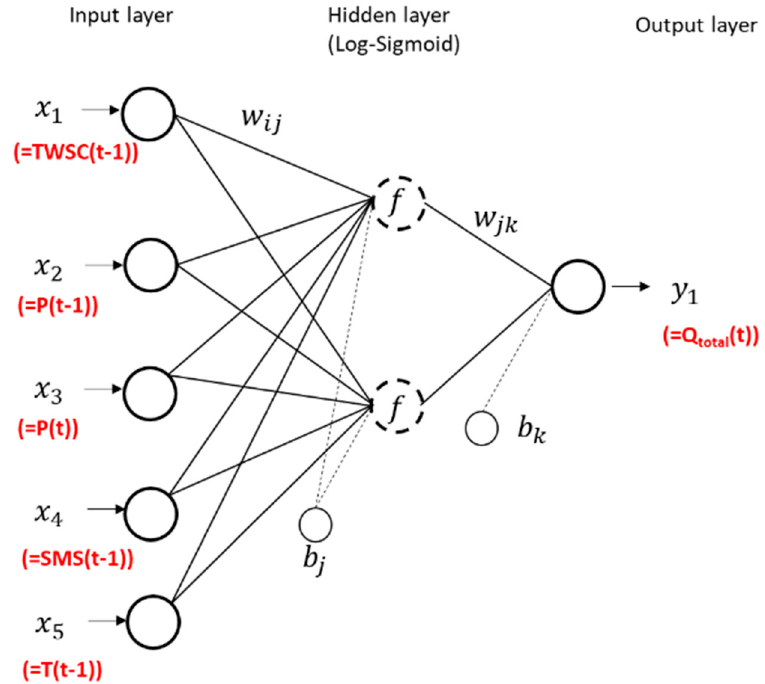
Figure 3. The artificial neural network (ANN) model architecture used for predicting total discharge. [ x ] are the input data, which are antecedent (t-1 indicates 1 month ahead) TWSC, precipitation (P), soil moisture (SMS), and average temperature (T). The prediction ( y 1 ) is the total discharge (Q total ). w ij and w jk denote connection weights, b j and b k are the bias term, and f represents the activation function (log-sigmoid). Table 3. Input data and target data corresponding to test cases. P: precipitation, T: average temperature, SMS: soil moisture, and IDW: inverse distance weighting.